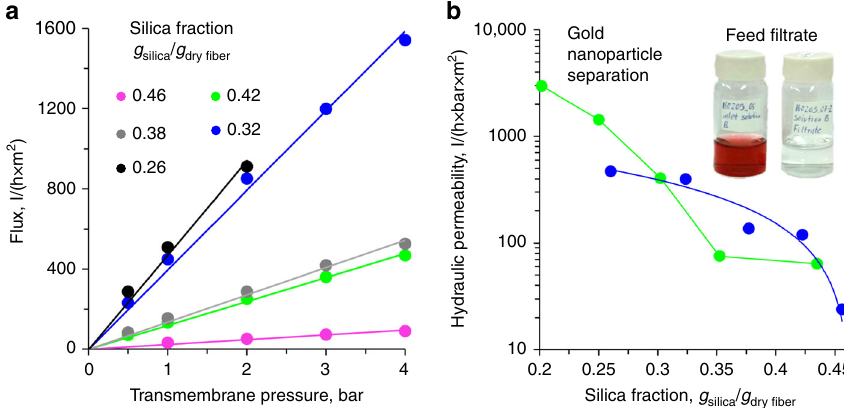
Fig. 3 Separation properties of STRIPS bijel-derived membranes. a Flux of pure water as a function of transmembrane pressure for membranes polymerized 5 cm from the nozzle with different silica nanoparticle fractions (40 mM CTAB, 0% EtOH in continuous phase). b Hydraulic permeability (i.e., slope of lines in a ) as a function of silica nanoparticle concentration for membranes polymerized at distances of 5 cm (blue points) and 30 cm (green points) from the extrusion nozzle (both 40 mM CTAB, 0% EtOH in continuous phase, curves are drawn to guide the eye). The inset shows photographs of a suspension of citrate stabilized gold nanoparticles before (feed, 0.01 wt% 20 nm Ag particles at pH 8) and after ( fi ltrate) fl owing through the membrane fabricated